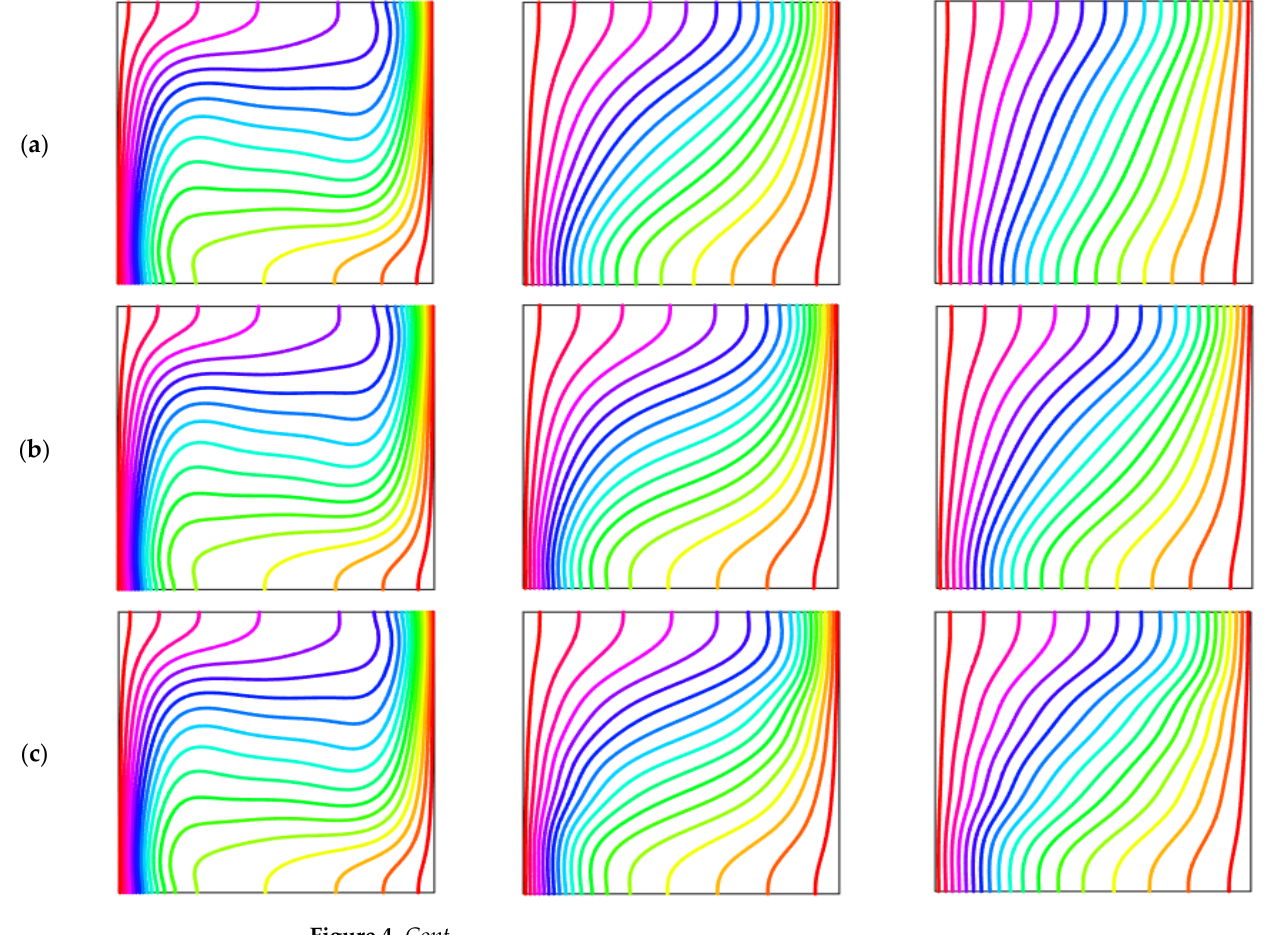
Ha = 60 Figure 4. Effect of isotherms for various Hartmann number ( Ha ) for ( a ) uniform magnetic field (umf), ( b ) λ = 0.1, ( c ) λ = 0.25, ( d ) λ = 0.5, and ( e ) λ = 1 when Ra = 10 6 , d = 10 nm, ϕ = 0.04, n = 3, Pr = 6.8377, and τ = 1.